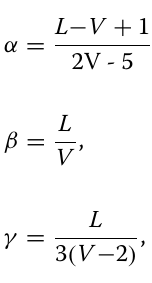
Table 2 Analysis of the landscape pattern index in